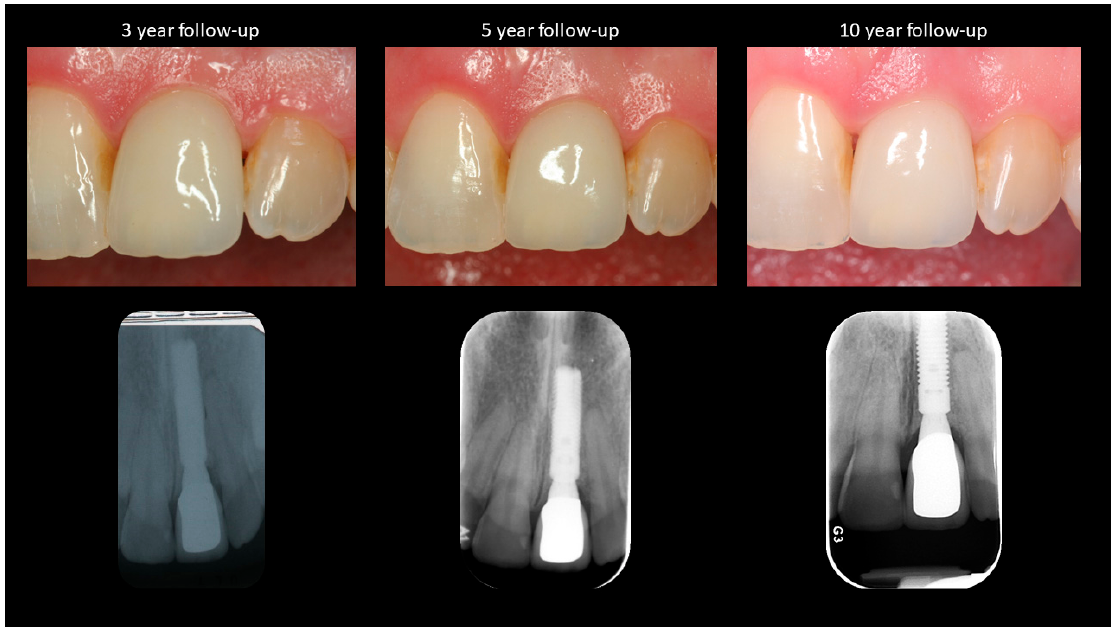
Figure 3. Peri ‐ implant soft and hard tissue levels at 3, 5, and 10 year follow ‐ up appointments.